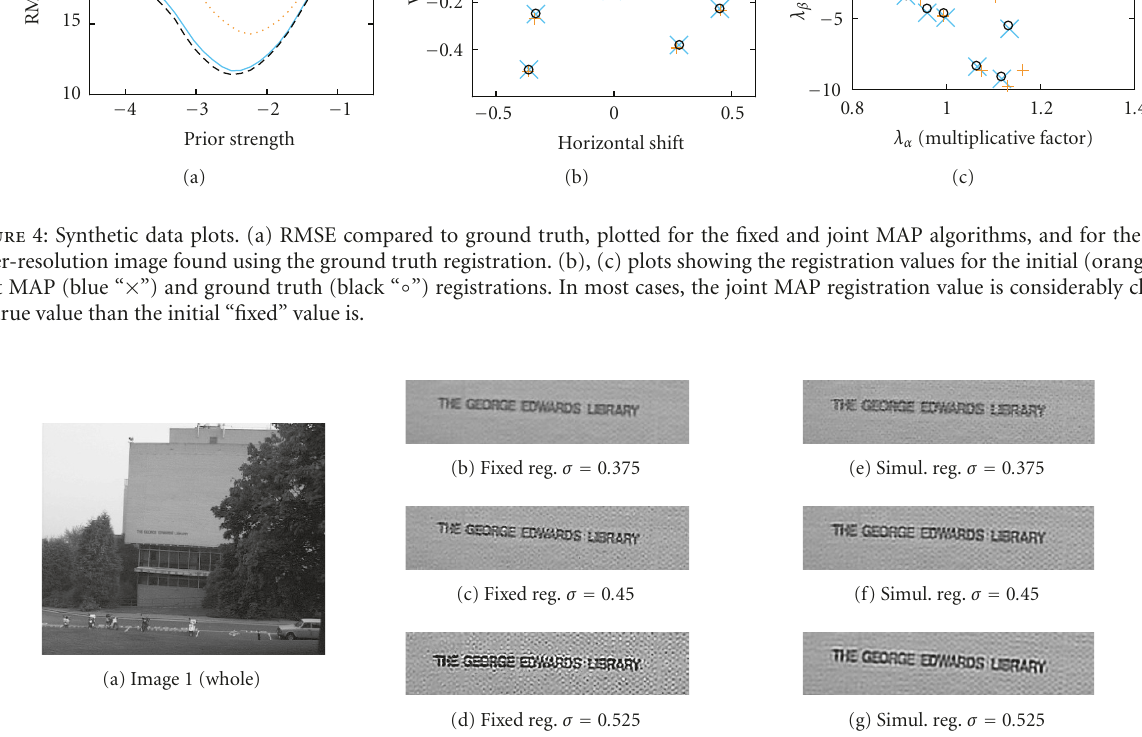
Figure 5: Surrey library sequence. (a) One of the 30 original images. (b), (c), (d) Super-resolution found using fixed registrations. (e), (f), (g) Super-resolution images using simultaneous MAP algorithm. Detailed regions of two of the low-resolution images can be seen in Figures 1(a),